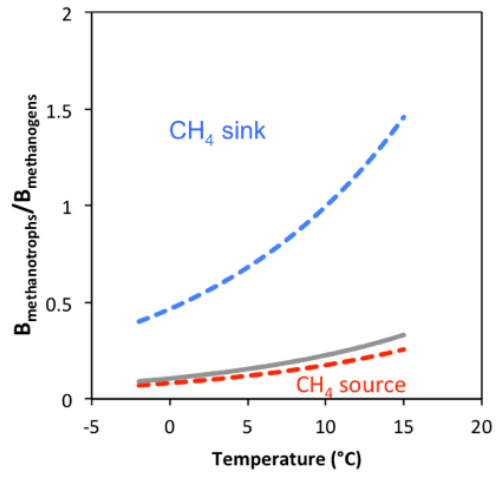
Figure 8. Simulations of active biomass ratio B methanotrophs /B methanogens distribution for Arctic soils to act as CH 4 sink or source in response to rising temperature. Dissolved CH 4 and O 2 concentrations of 0.1mM in soil pore water are assumed. Half saturation constants ( K m , CH represent the baseline value (grey), high (blue), and low (red) range for sensitivity analysis. Biomass ratios below the curves indicate the system could be a CH 4 source, while biomass ratios above the curves suggest a CH 4 sink.